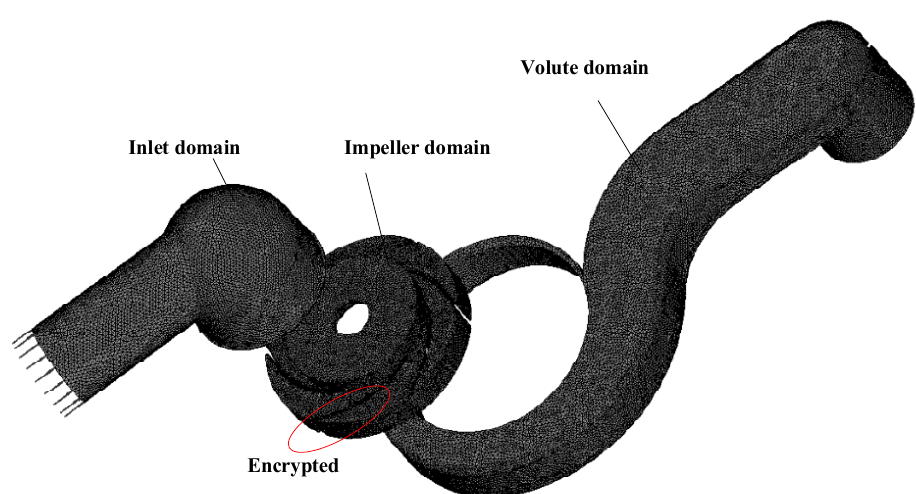
Figure 4. Analysis of mesh independence.